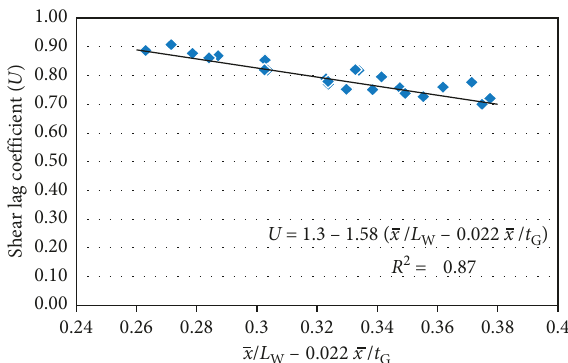
Figure 15: Proposed equation for the single angle compared to FE results.